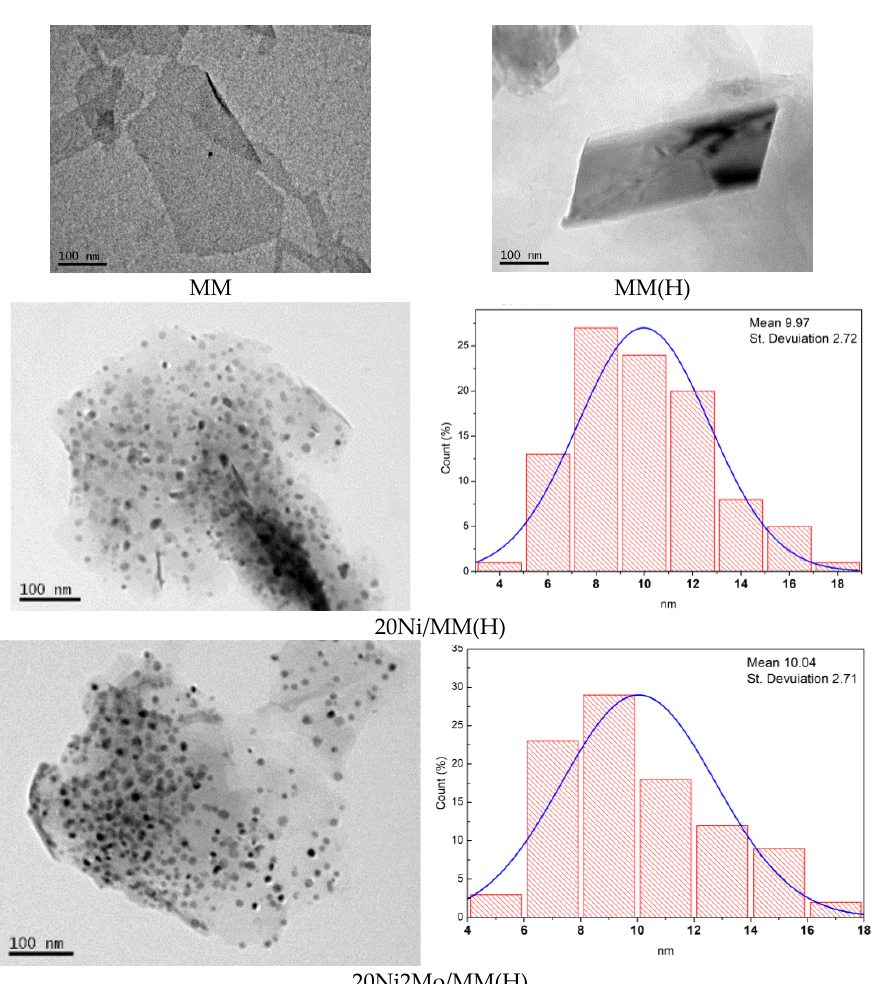
Figure 6. Representative TEM images and the corresponding nickel particle size distributions. Examining the mineral montmorillonite at the microscale, we observed that agglom- erates of the plate-shaped support nanoparticles, as determined by TEM (Figure 6), con- stituted flower-like assemblies, as shown in the representative SEM images recorded at much lower magnification for the three samples taken as examples (Figure 7). A similar morphology was observed at even smaller magnification.